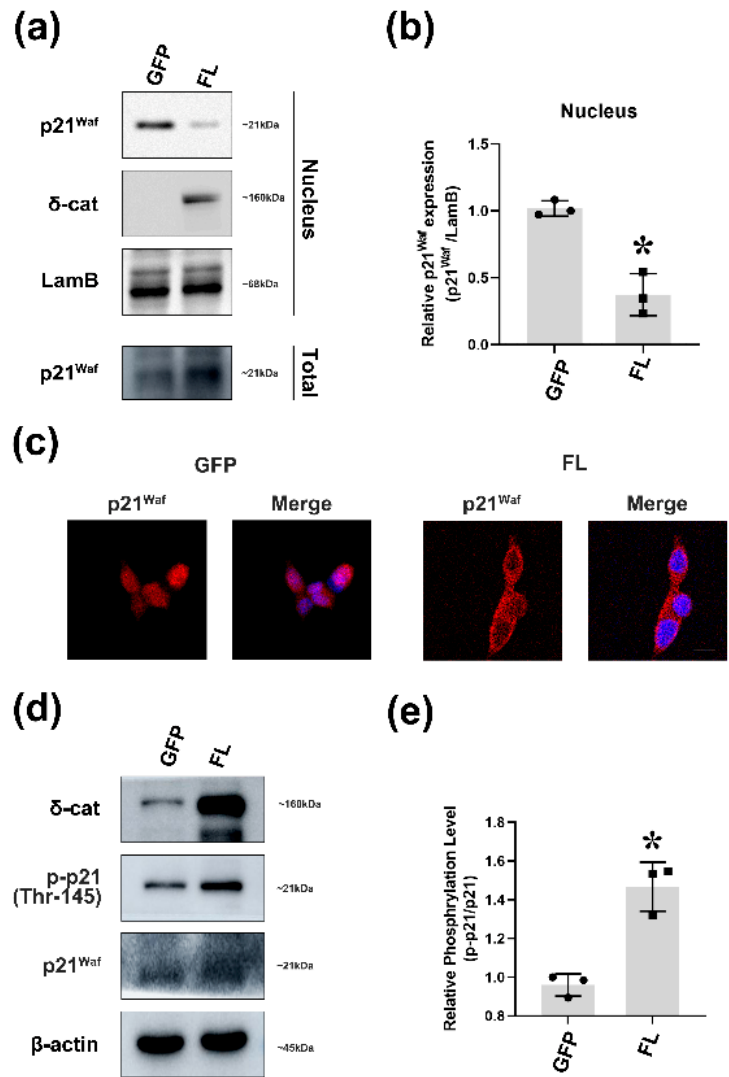
Figure 2. δ -catenin blocks p21 nuclear accumulation through stabilization of p21 in the cytoplasm. ( a ) Rv-1 cells were transfected with GFP or GFP- δ -catenin. Nuclear p21 levels were measured by immunoblotting with anti-p21 waf , anti- δ -catenin, anti-LamB. This experiment was repeated independently three times. ( b ) Densitometry data of p21 from ( a ) were normalized using LamB (Nucleus) densitometry data. Quantitate p21/LamB. * p < 0.001 vs. GFP ( c ) Immunofluorescence images of Rv-1 cells transfected with respective plasmid were labeled with indicated antibodies against p21. Sections were co-stained with DAPI to visualize nuclei. Scar bar: 100 µ m. ( d ) Rv-1 cells were transfected with GFP or δ -catenin-GFP. Cell lysates were immunoblotted with anti-p-p21 (Thr-145), anti-p21 waf , anti- δ -catenin, and anti- β -actin. This experiment was repeated independently three times. ( e ) Quantitation of p-p21/p21 in ( d ). * p < 0.001 vs. GFP. All p -values were determined with unpaired Student’s t -test: *, p < 0.001.